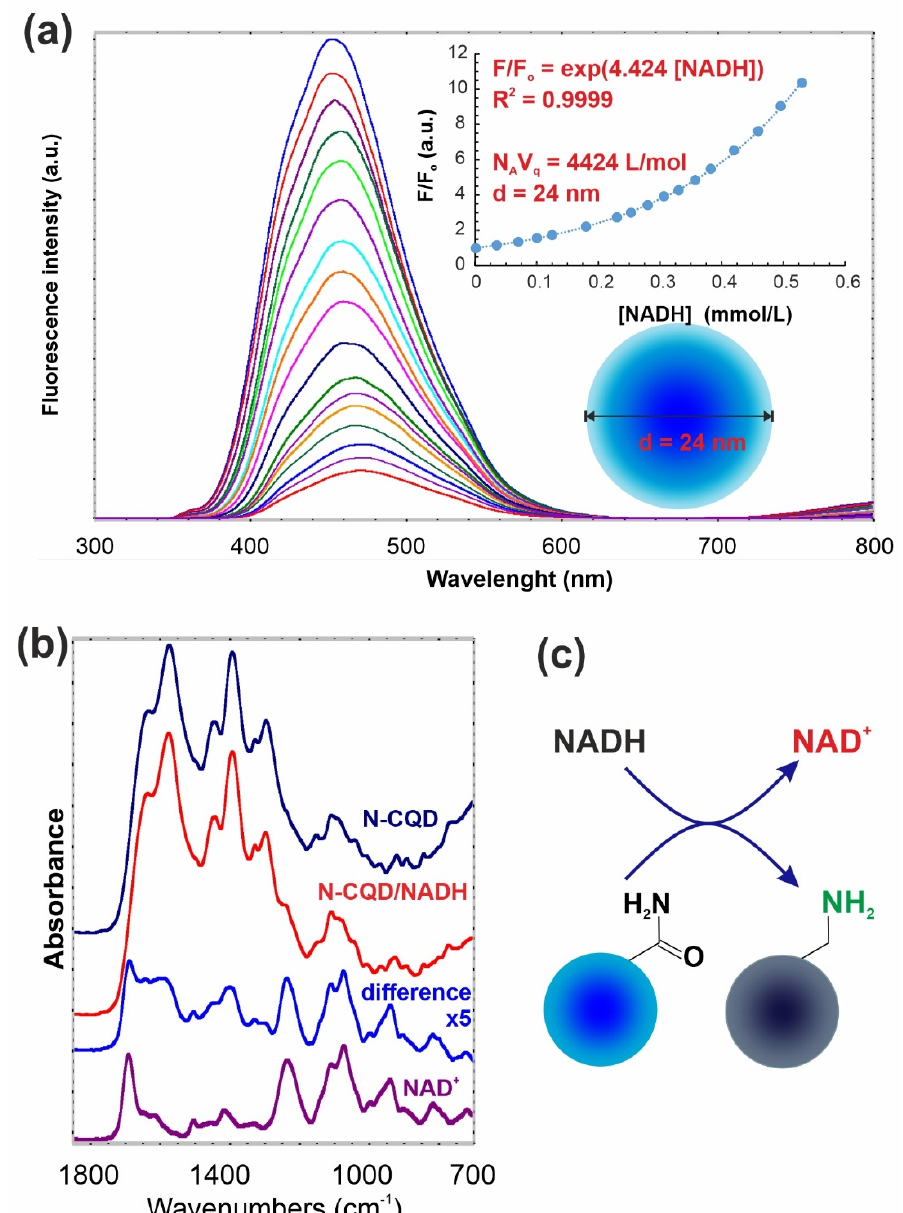
Figure 7. ( a ) Fluorescence emission spectra of N-CQD and their quenching by sequential addition of reduced form of nicotinamide adenine dinucleotide (NADH) aliquots. Inset shows Stern–Volmer plots for quenching with various concentrations of NADH. F o is the fluorescence intensity of initial sample, while F means observed intensities; ( b ) FTIR spectra of NAD + and N-CQD/NADH complex, and blue spectrum is the differential one; ( c ) schematic representation of the processes underlying the observed phenomenon.